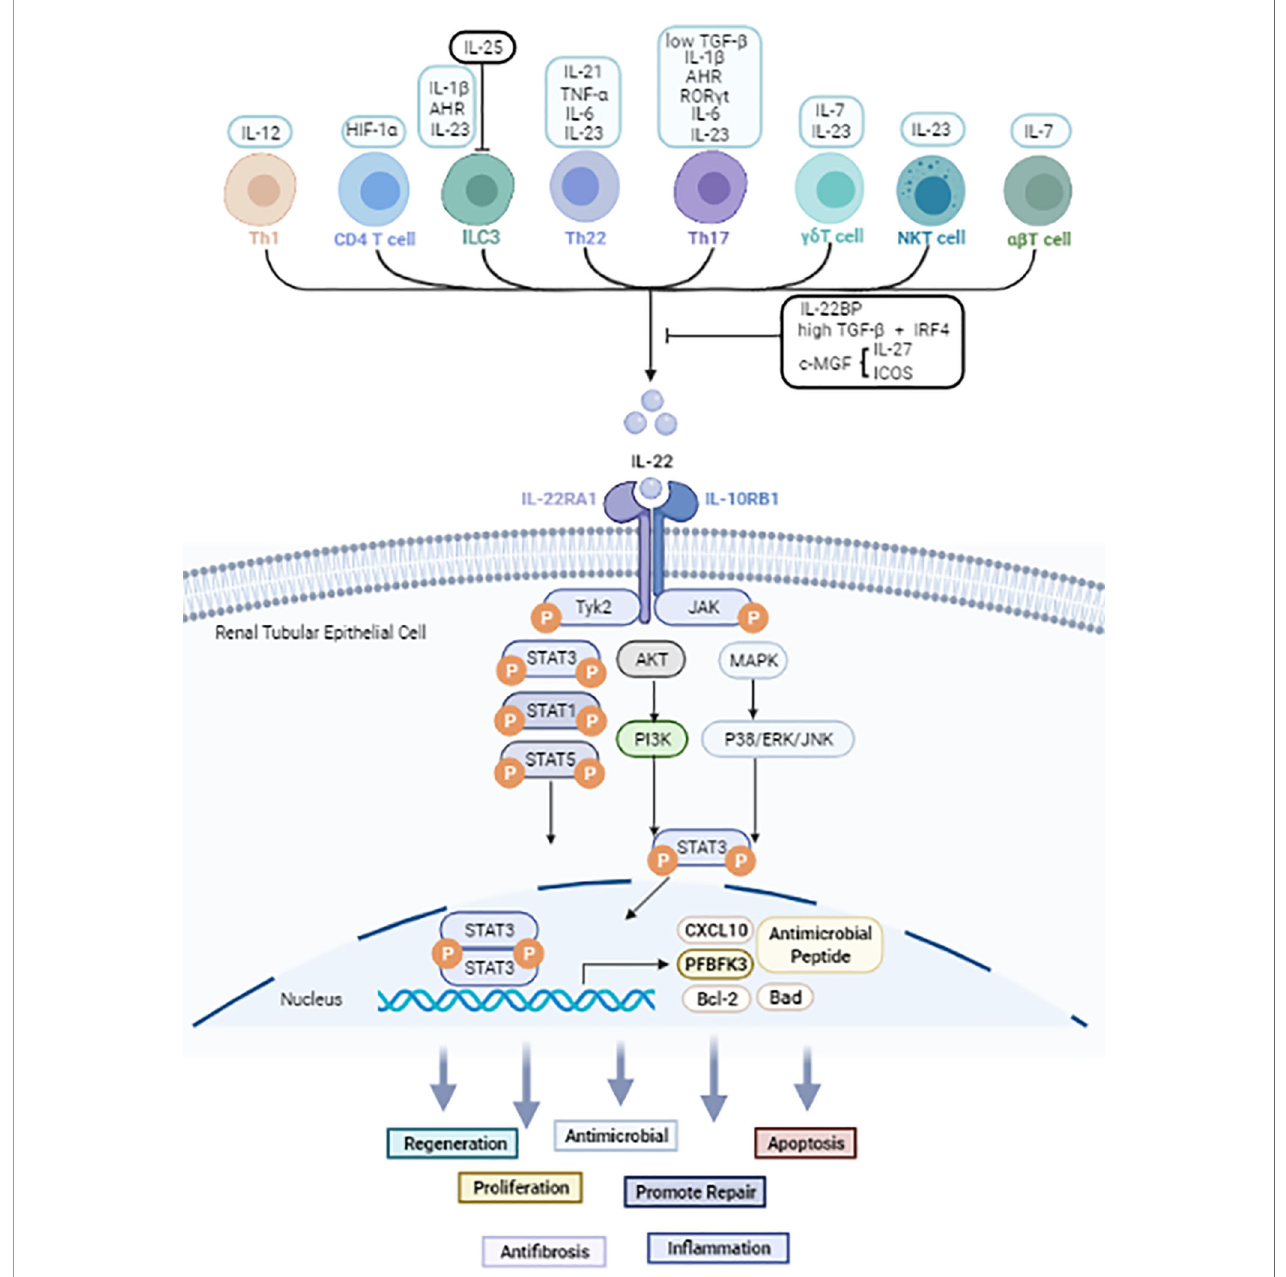
FIGURE 1 | The cellular sources and signals downstream of IL-22 based on current evidence. Black arrow: upregulate. Black line: inhibit. IL-22 is secreted mainly by immune cells. JAK1 and TYK2 molecules are fi rstly phosphorylated after IL-22 binds to the IL-22R complex. Then further phosphorylate STAT molecules thus causes dimerization and accompanying translocation of STATs to the nucleus. Usually, STAT3 molecules play a pivotal effect, but STAT1 and STAT5 also be involved. Other than JAK/STAT activation, IL-22 also can activate AKT/PI3K and MAPK/P38/ERK/JNK pathways. IL-22 promotes the transcription of proteins such as Bal2, CXCL10 and PFBFK3, and has biological effects including anti-in fl ammatory, anti-microbial, apoptotic, anti- fi brotic, and proliferative effects in kidney, liver, gastrointestinal tract, and